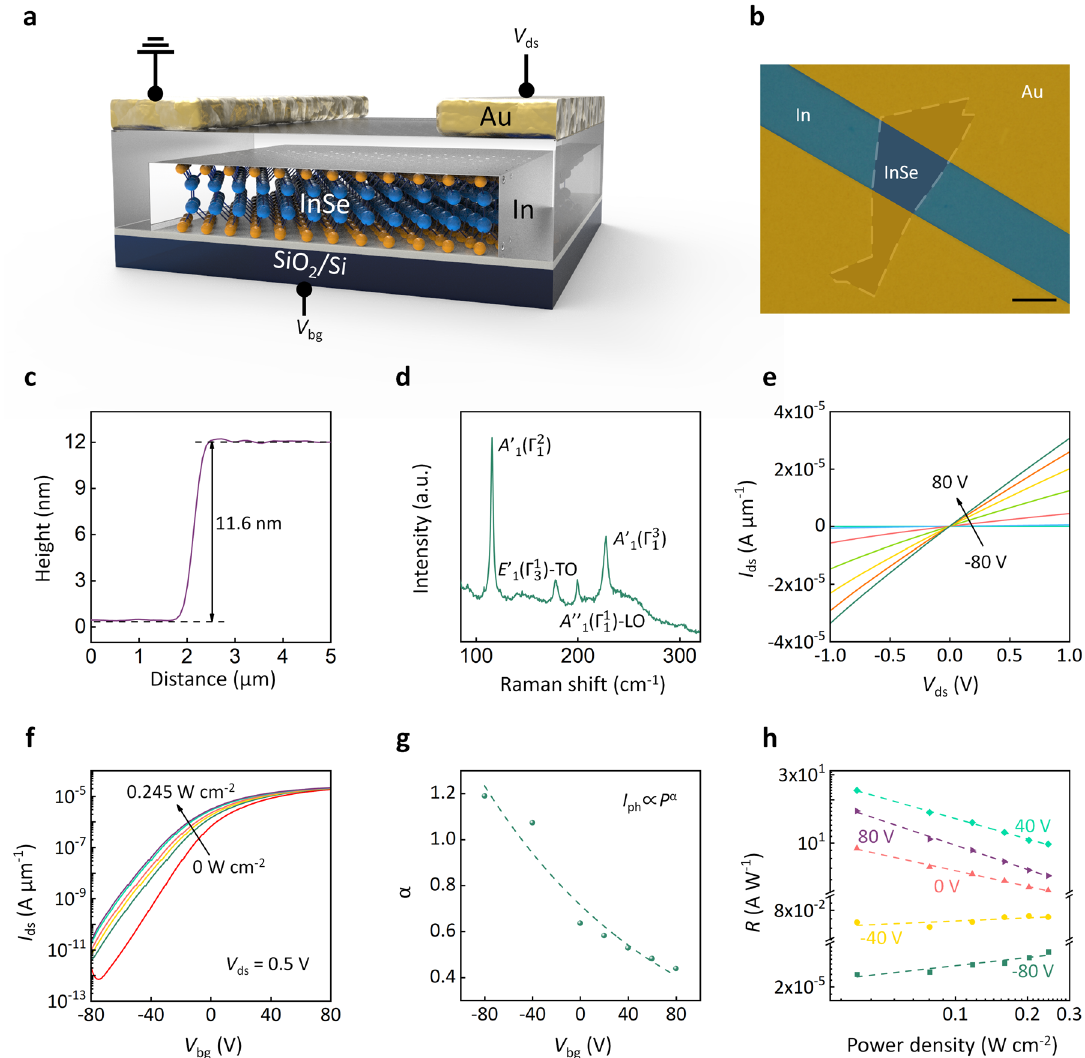
Fig. 1 Characterization, electrical and optical properties of multilayered InSe device. a Schematic sketch of the back-gate InSe-based device. b Optical image of the multilayered InSe device. Scale bar: 10 μ m . c Height pro fi le of the layered InSe channel. d Raman spectrum of the InSe fl ake with an excitation wavelength of 532 nm. e Output characteristics of the InSe device tested in the dark at various V bg . f Transfer characteristics at different illumination intensities of a 405-nm laser at V ds = 0.5 V. g The extracted α value as a function of V bg . h Responsivity ( R ) of the InSe device as a function of the laser power density under diverse V bg with V ds = 0.5